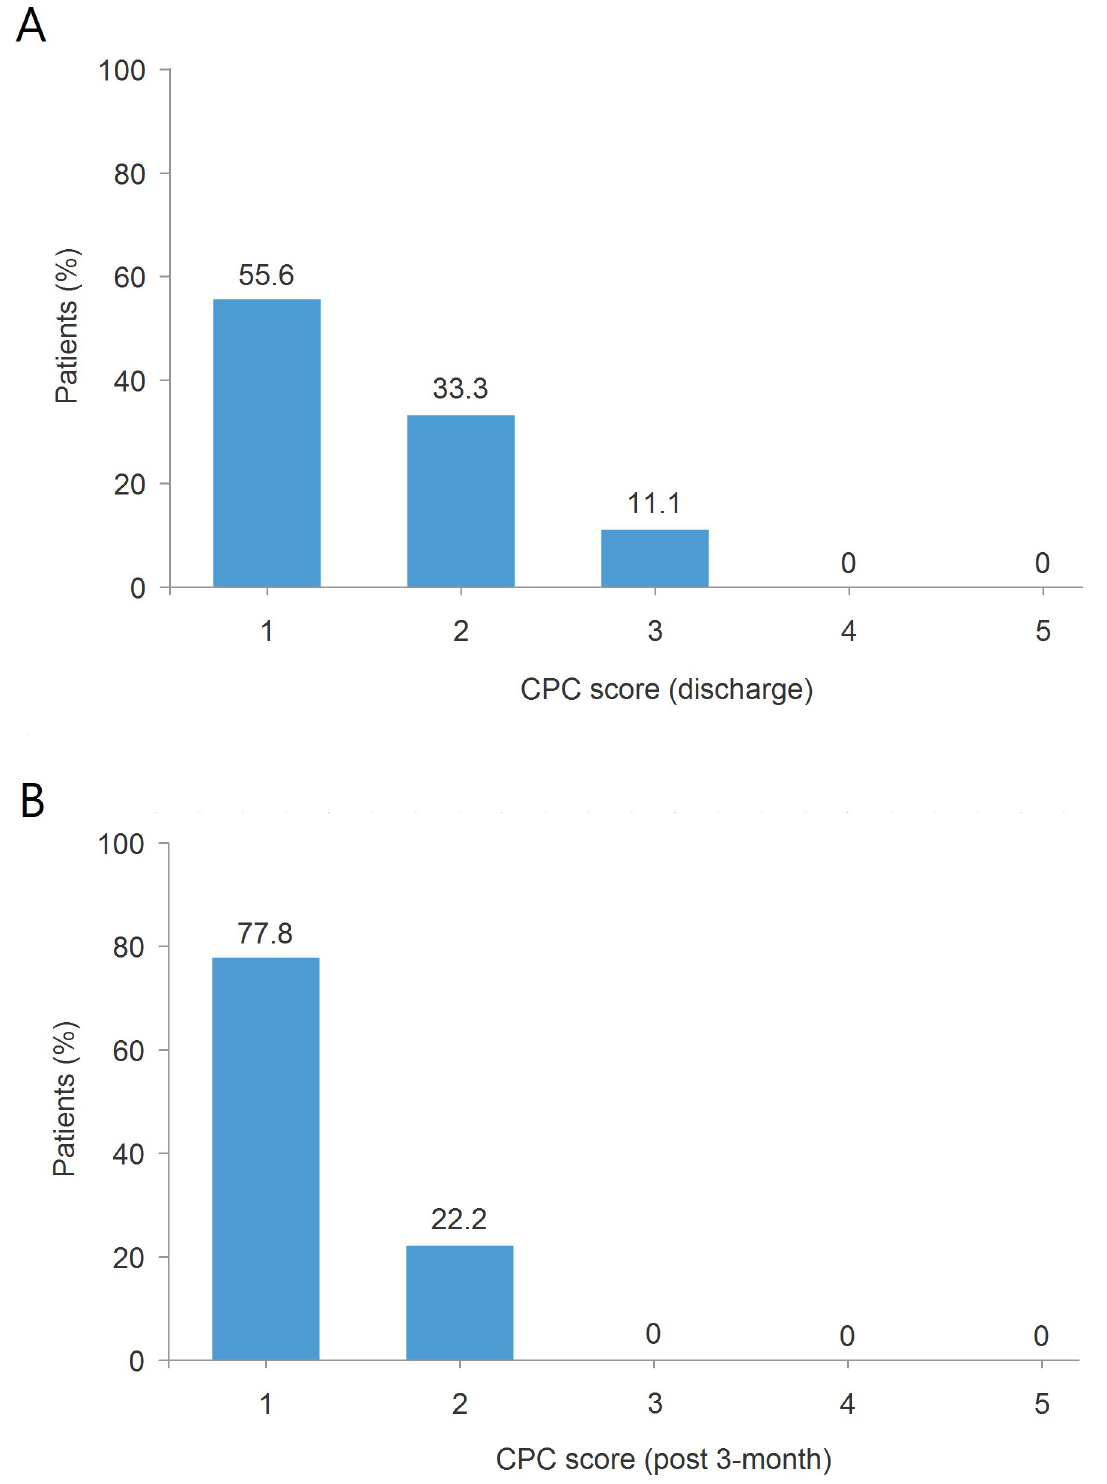
Fig 4. CPC score for 9 survivors at discharge (A) and at 3 months after discharge (B). CPC, cerebral performance categories.